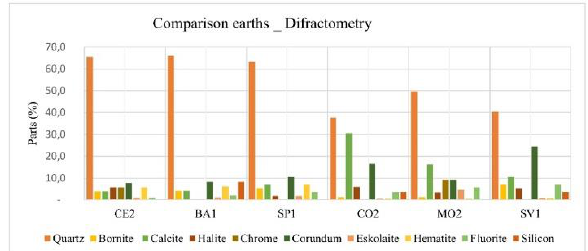
Figure 9. Comparison of earth's diffractometries, reworked by the authors.